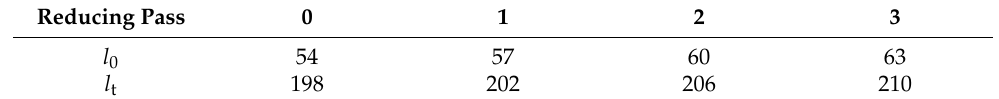
Table 3. Dimensions of each pass tensile specimen (mm).